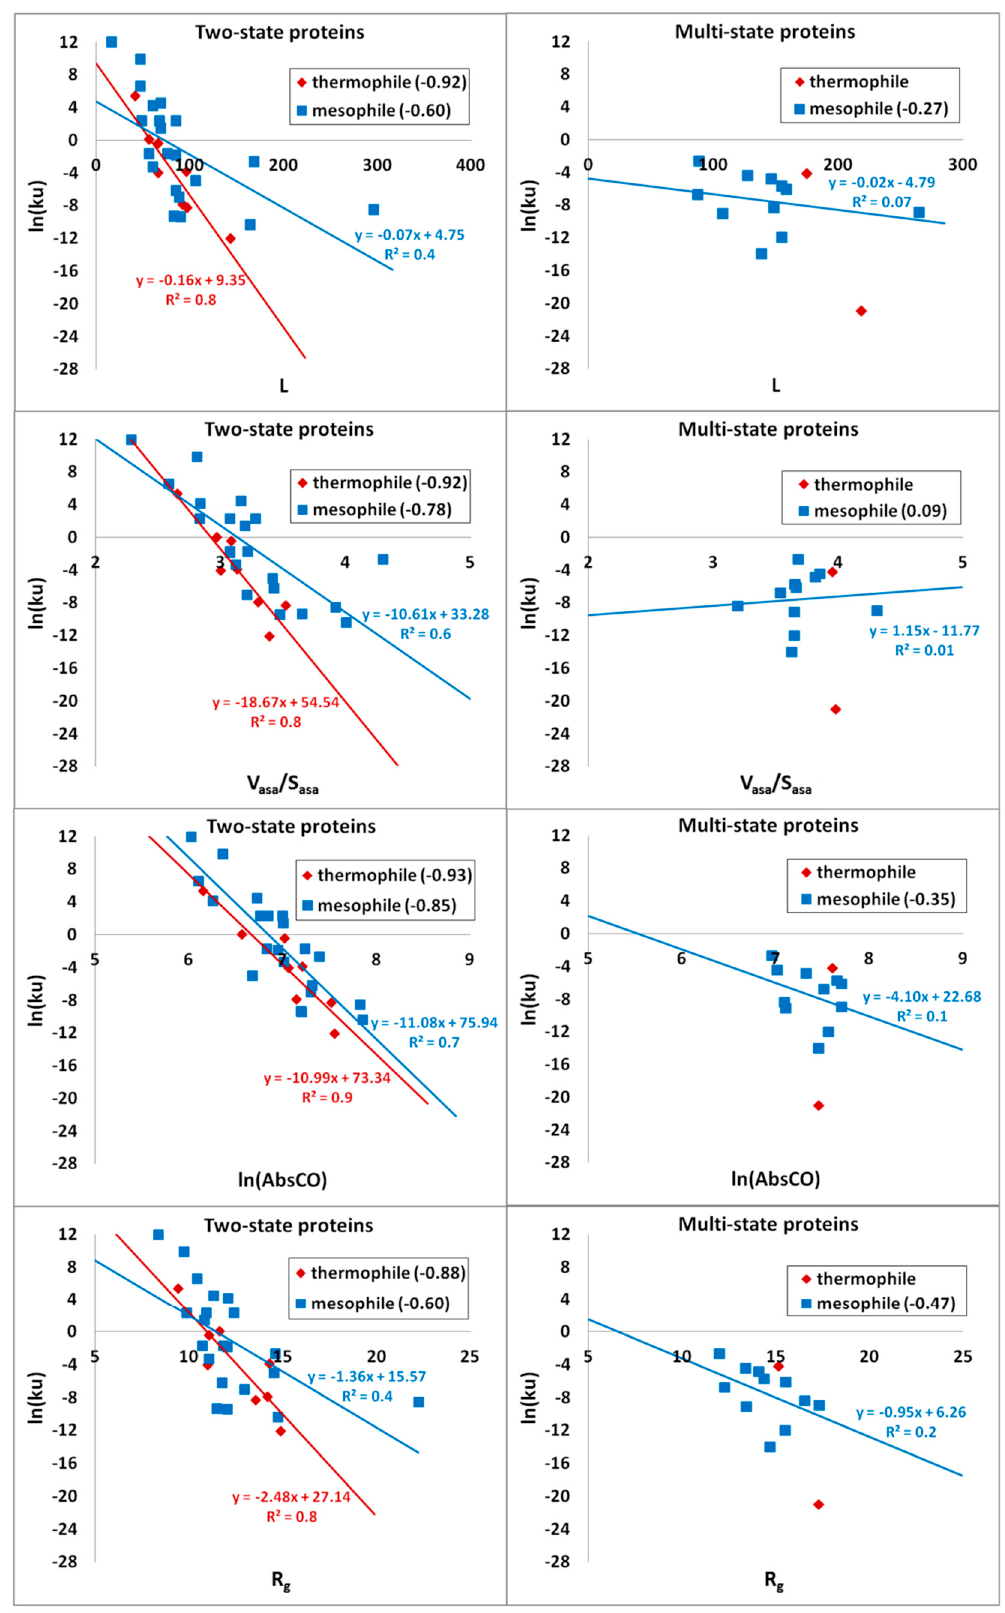
Figure 8. Correlations of the logarithm of the unfolding rate of the two- and multi-state thermophilic and mesophilic proteins with structural parameters: L (length of the protein), V asa / S asa , ln(AbsCO), and R g . There is a line approximation of points and its equation: red line corresponds to thermophilic proteins and blue line to mesophilic proteins. R 2 is a linear approximation reliability.